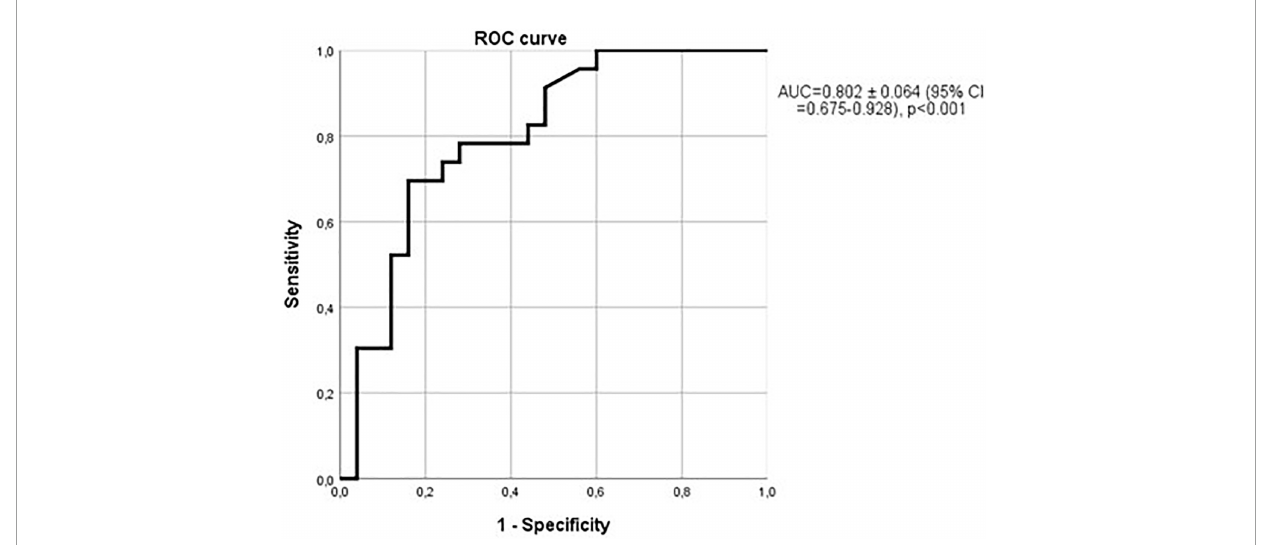
FIGURE13 Relationship between sclerostin and cella media values over the median in non-hypertensive patients with vessel wall calcium deposits. AUC = 0.802 ± 0.064; (95% CI = 0.675–0.928); p <